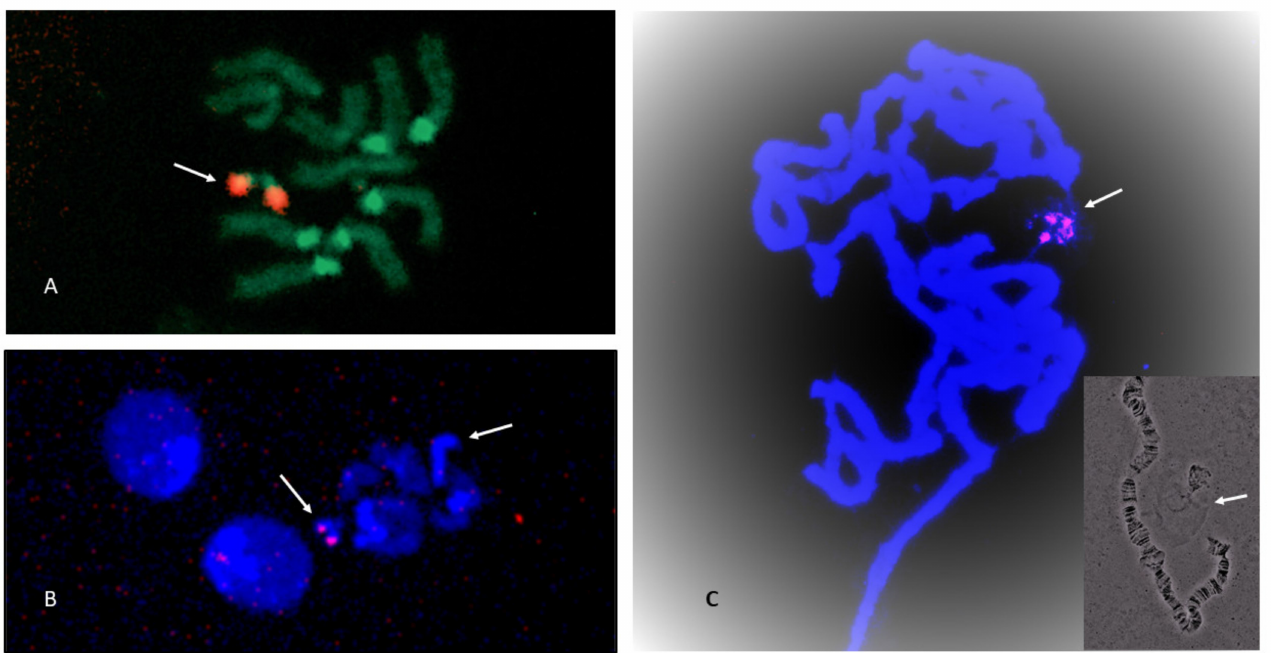
Figure 6. NOR sites on Scaptodrosophila sp. aff. concolor strain CBN17 chromosomes as shown by FISH. ( A ) Female with hybridization to ‘dot’ chromosomes (arrow). The rRNA technique was used. ( B ) Male with hybridization to ‘dot’ chromosomes. Second arrow indicates heterochromatic Y chromosome. An rDNA probe was used. ( C ) Polytene chromosomes with hybridization to nucleolar RNA. The rRNA technique was used. Insert shows close association between polytene ‘dot’ chromosome and nucleolus with extending strands of DNA.